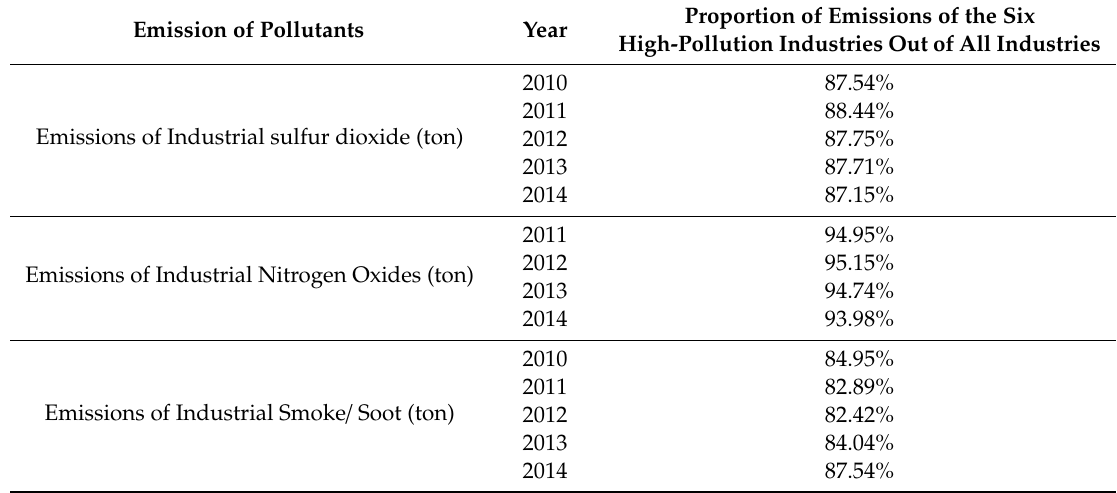
Table 1. Gas emissions of the six high-pollution industries from 2010 to 2014. Emission of Pollutants